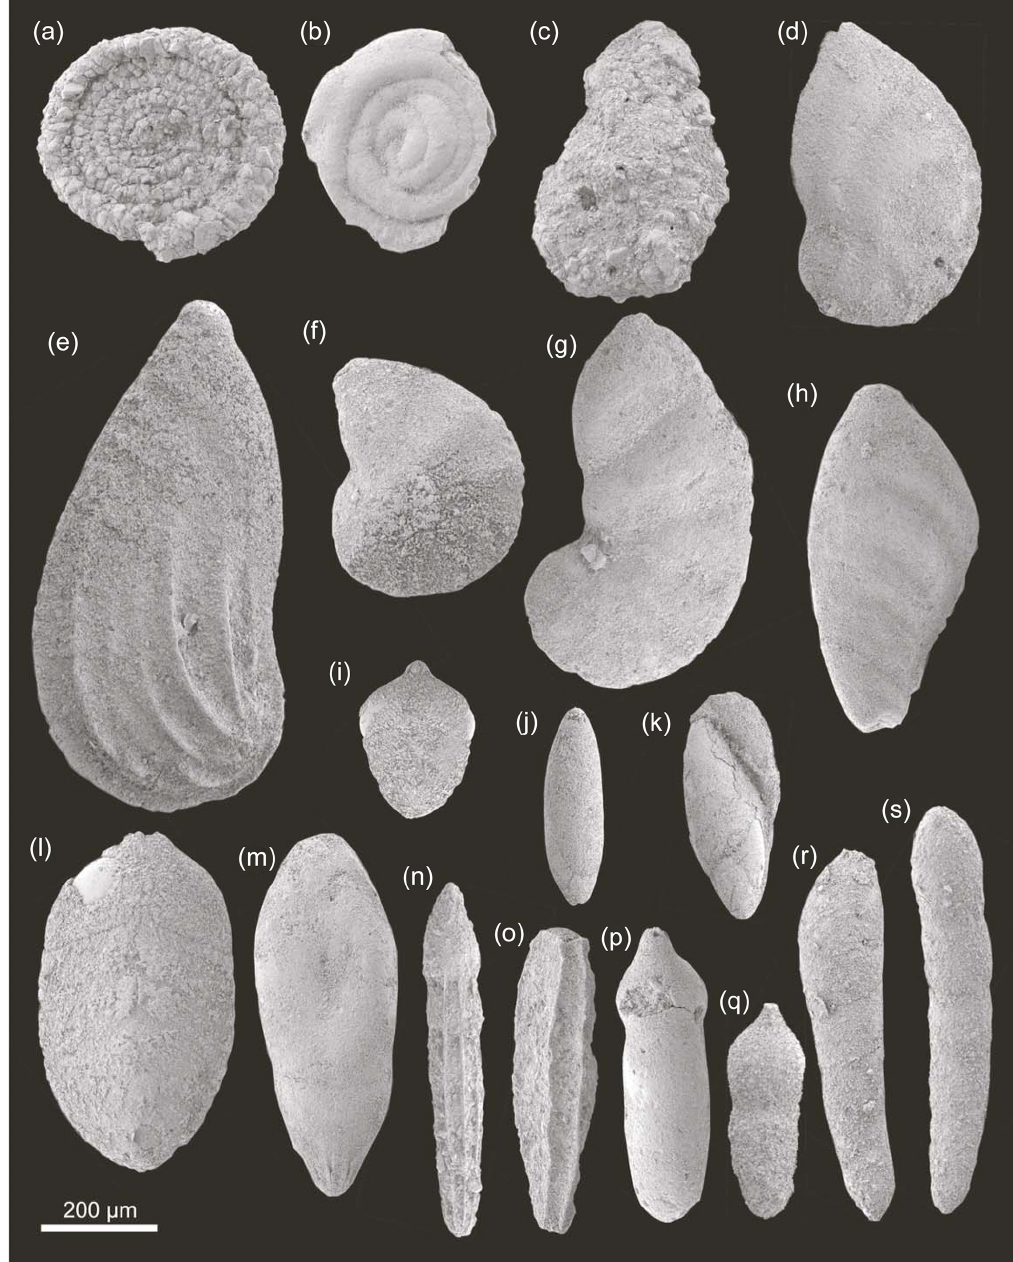
Figure 6. SEM images of benthic foraminifera from the Cueva del Agua section. (a) Ammodiscus . (b) Glomospira . (c) Ammobaculites . (d) Astacolus . (e) Planularia . (f) Lenticulina . (g) Marginulinopsis . (h) Vaginulinopsis . (i) Pseudonodosaria . (j, k) Eoguttulina . (l) Tristix . (m) Pseudonodosaria . (n) Nodosaria . (o) Paralingulina . (p, q) Pseudonodosaria . (r, s) Dentalina